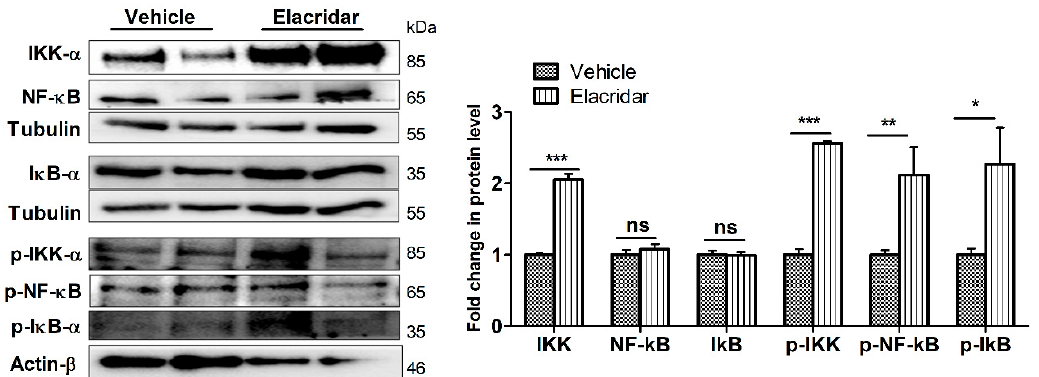
Figure 7. Treatment with elacridar (10 mg/kg) i.p. for 28 days significantly activated the NF- κ B pathway in TgSwDI mouse brains. Representative Western blot and densitometry analysis, presented as fold change by elacridar on each protein compared to vehicle treatment, demonstrated that elacridar significantly increased expression of IKK- α , p-IKK- α , p-NF- κ B, and p-I κ B- α . Statistical analysis was determined by Student’s t -test. Data represented as mean ± SEM of n = 5 mice per group, ns = not significant, * p < 0.05, ** p < 0.01, *** p < 0.001 compared to vehicle-treated group. kDa indicates the molecular weight of analyzed proteins.